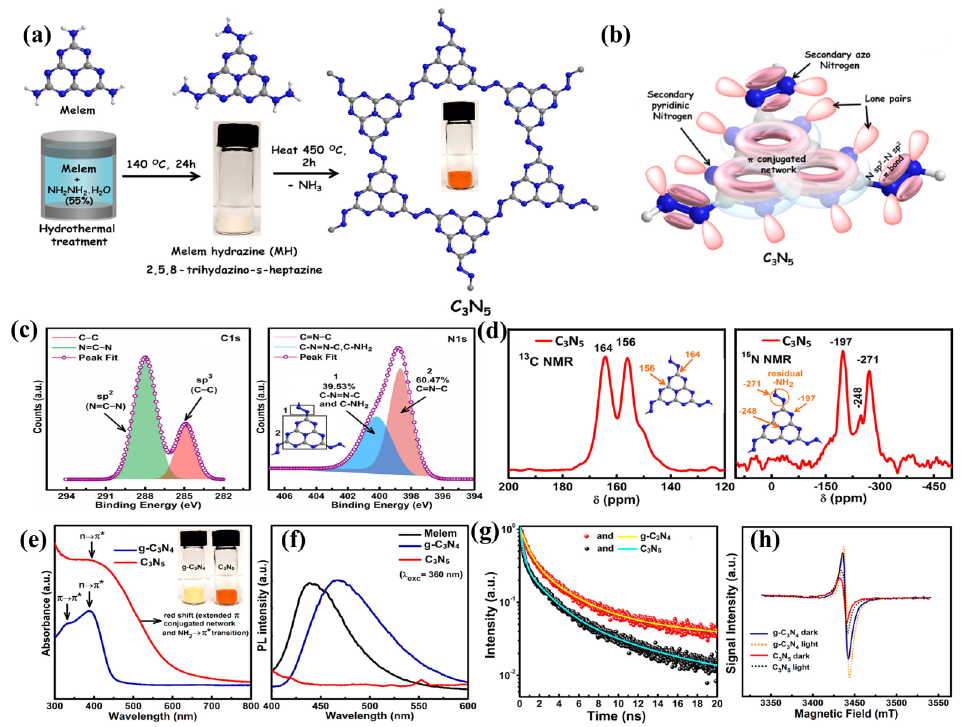
Figure 6. ( a ) Synthesis route; ( b ) molecular orbital overlap representation; ( c ) HR − XPS spectra (left: C1s, right: N1s); ( d ) CPMAS NMR spectra (left: 13 C, right: 15 N); ( e ) UV − vis spectra (blue: g − C 3 N 4 ; red: g − C 3 N 5 ); ( f ) steady state PL spectra; ( g ) PL lifetime decay curves; ( h ) X − band EPR spectra; Adapted with permission from [4]. Copyright American Chemical Society, 2019.